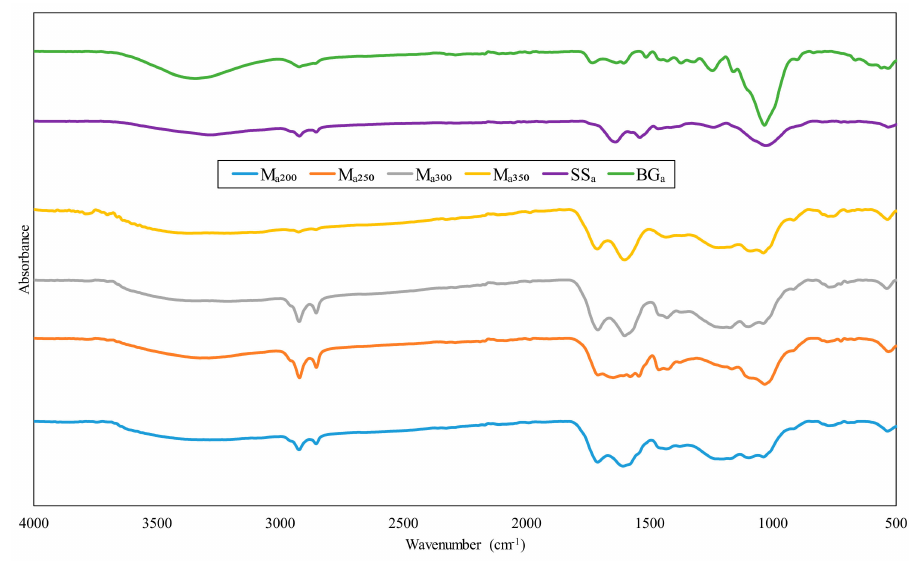
Figure 5. Infrared (IR) spectra for 50:50 mixing ratio of torrefied sewage sludge and sugarcane